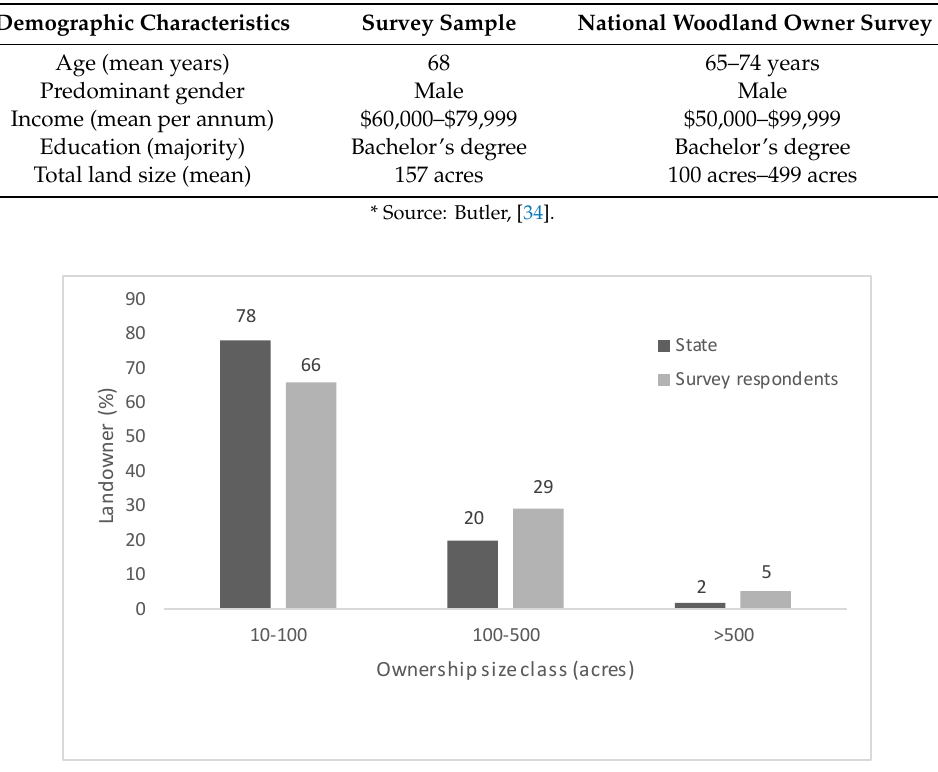
Table 1. Comparison of Mississippi’s Non-industrial Private Forest (NIPFs) sample estimates obtained via a mail survey with estimates reported in the National Woodland Owners Survey.